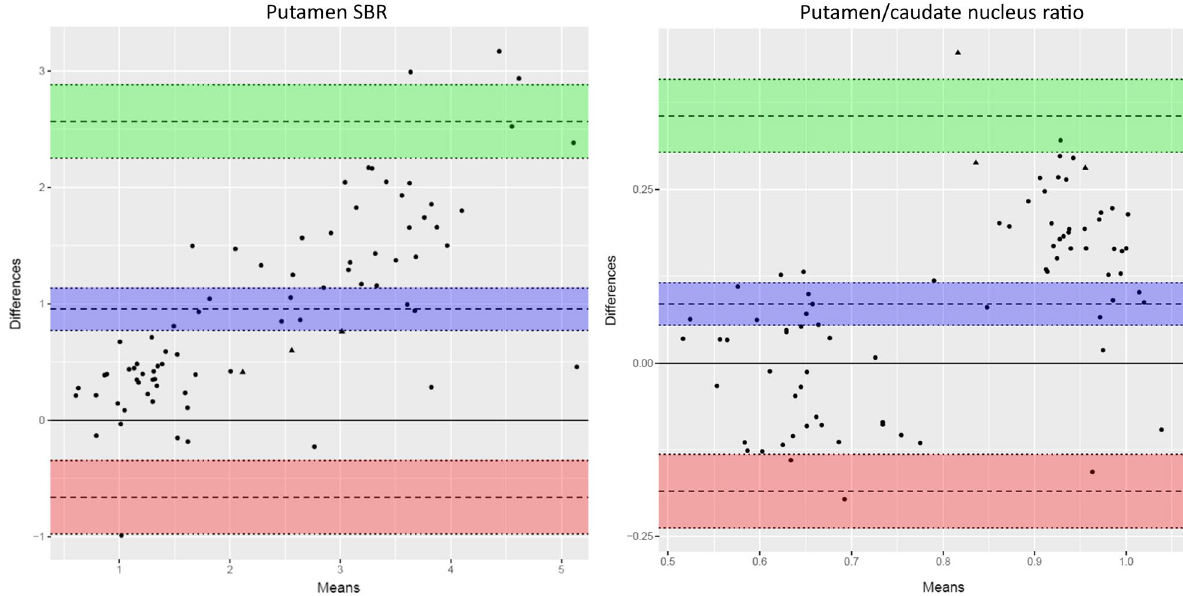
Fig. 6 PET versus SPECT Bland–Altman plots. Same data as in Fig. 5 shown as Bland–Altman plots. Triangles represent patients with discrepancy between PET and SPECT reading. The purple area represent the mean difference with 95% confidence limits (C.I.), the green area represent the upper limit of agreement with 95% C.I., and the red area the lower limit of agreement. As expected PET show relative higher values for putamen SBR (left) for PET compared to SPECT with 95% of patients being within 50% difference. Putamen/caudate nucleus ratio (right) show similarly relatively higher values but the difference is smaller and within